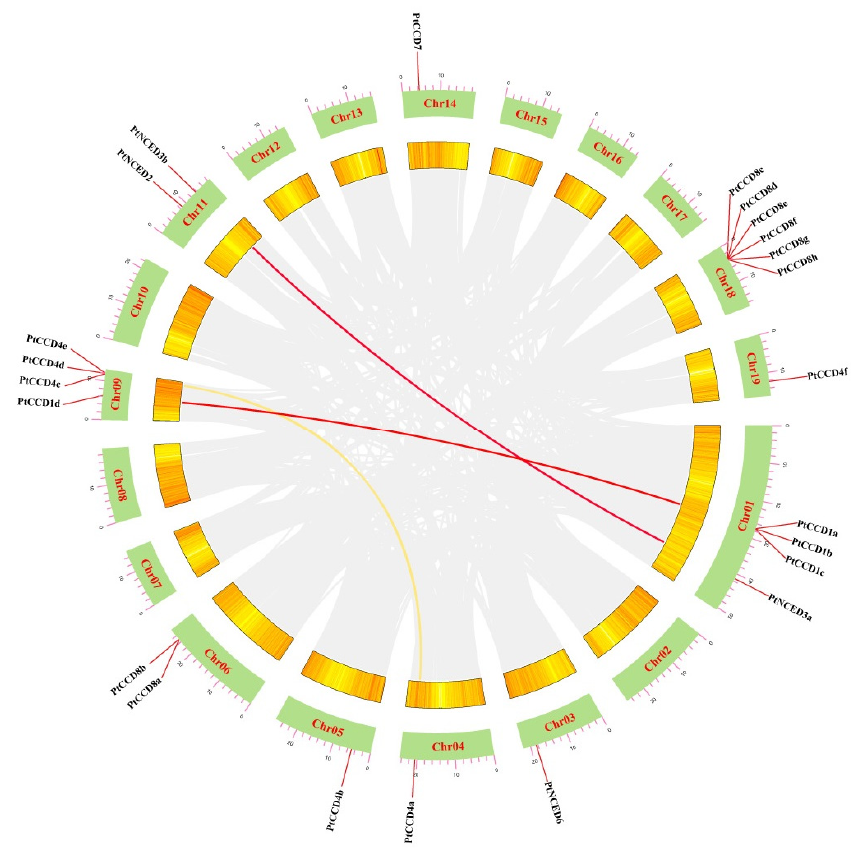
Figure 3. The collinearity analysis of PtCCDs . Chromosomes 01–19 were indicated using green rectangles. The homologous PtCCD genes in the poplar genome were displayed using red and yellow curves. The poplar gene with collinearity relationship was represented using gray curves.